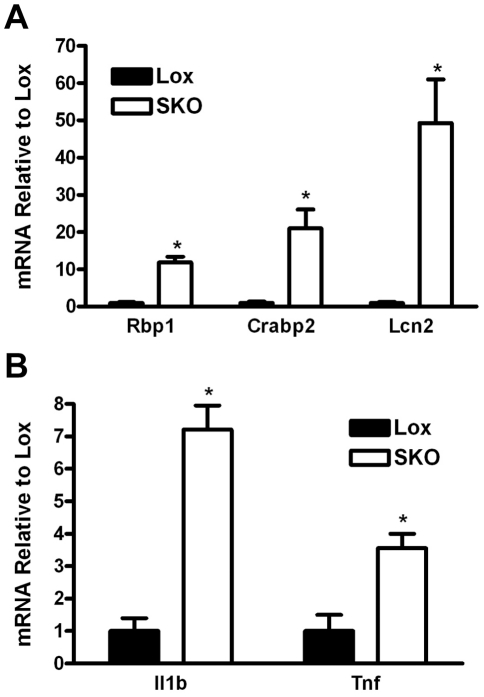
Elevated retinoic acid metabolism and inflammatory genes in 23 day old SKO skin.RNA was isolated from skin of 23 day old postnatal Lox and SKO mice and subjected to real-time PCR analysis and normalized to levels of 18S as described in
Methods
. The expression of A) retinoic-acid regulated genes (Lcn2, Rbp1, Crabp2) and B) inflammation genes (Il1b, Tnf) were significantly elevated in SKO mice at 23 days. All values are expressed as fold difference relative to Lox mice. Data represent mean ± SEM for n = 4–6 per group. * = p<0.05.